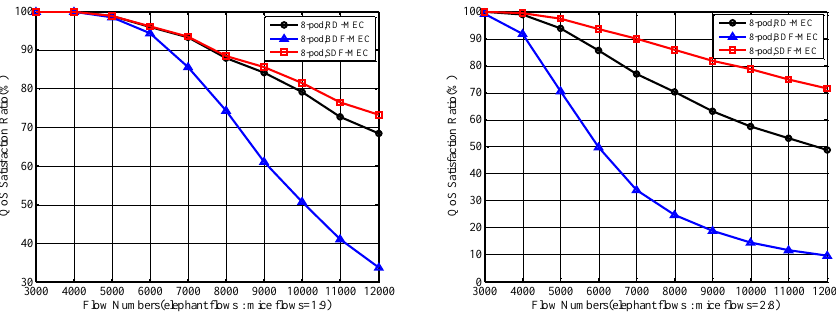
Figure 5. QoS satisfaction ratio of RD-MEC, BDF-MEC, and SDF-MEC in 8-pod Fat-Tree.